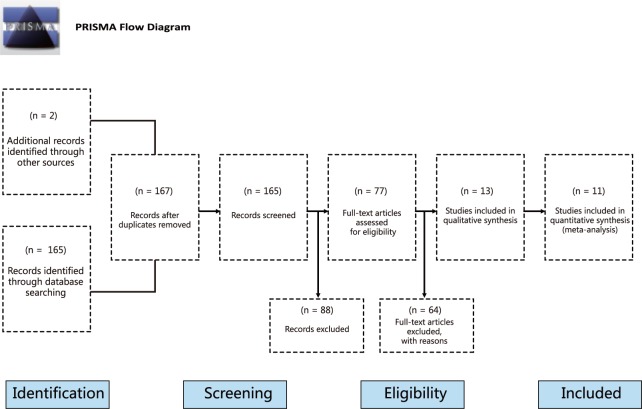
Flow chart of literature search and study selection.Eleven case-control studies were included in this meta-analysis.